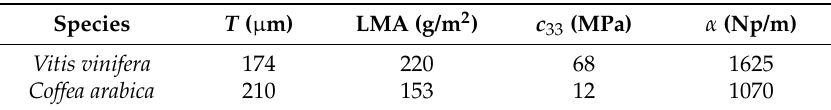
Table 3. Extracted leaf parameters from thickness resonance spectra in Figure 3 for Vitis vinifera and Coffea arabica leaves.